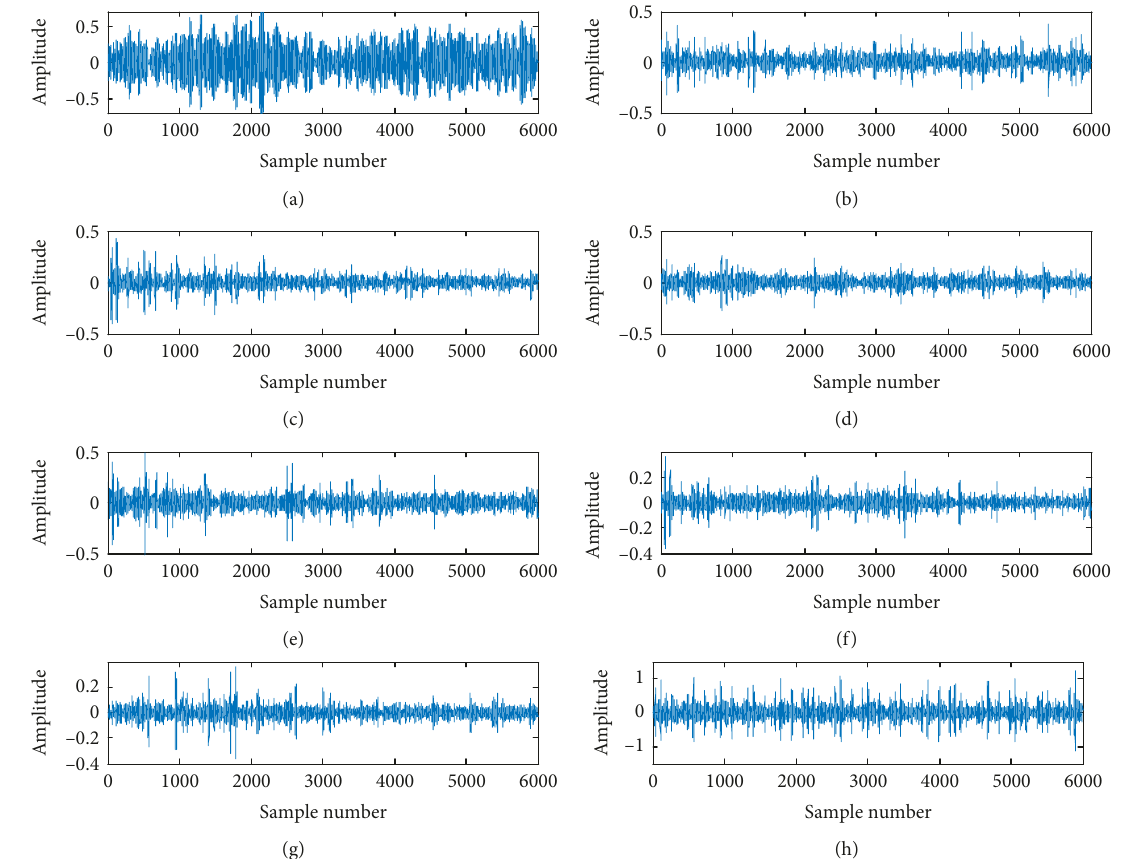
Figure 7: Multiresolution DMD modes of roller bearing’s inner race fault signal